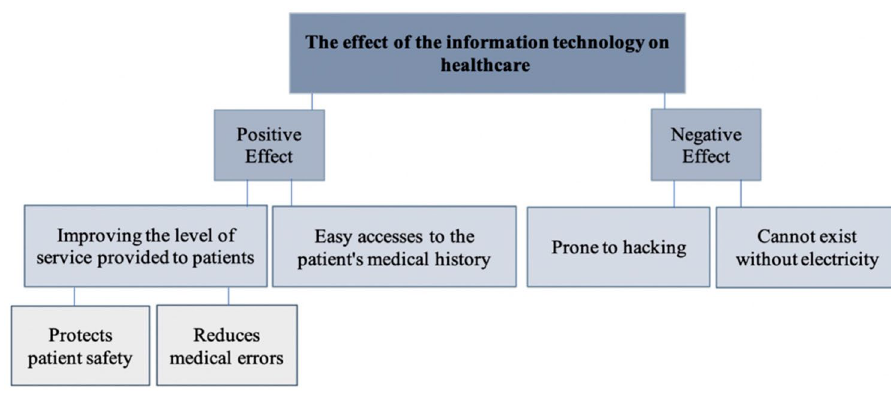
Fig. 2 The effect of IT on healthcare settings